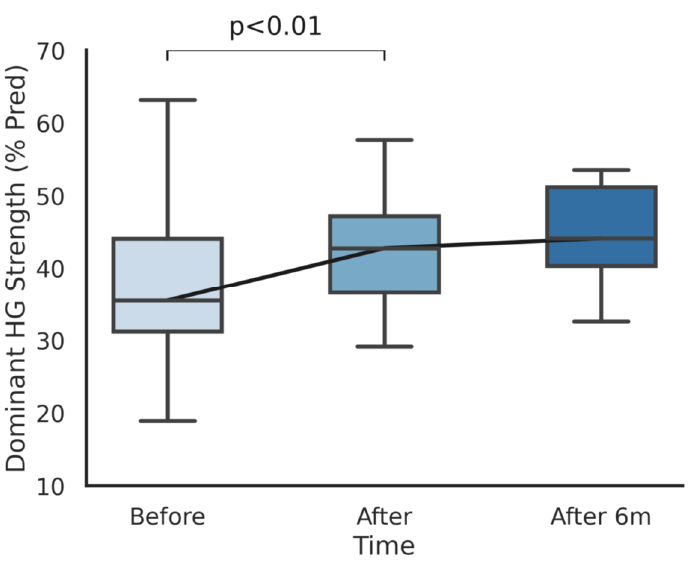
Figure 1. The percentage of predicted handgrip strength in the dominant hand before, after, and 6 months after the completion of the cardiopulmonary rehabilitation program.